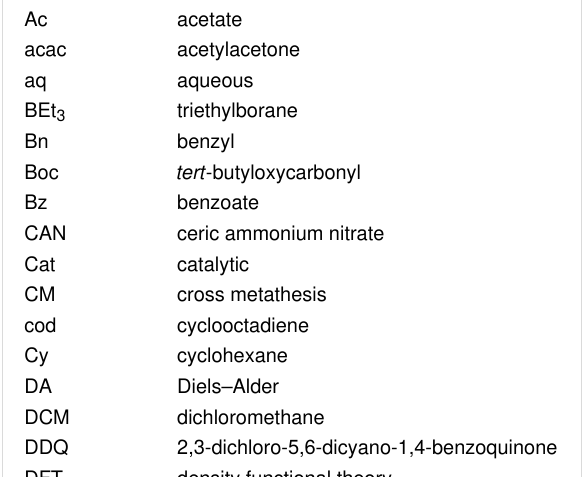
Table 1: List of